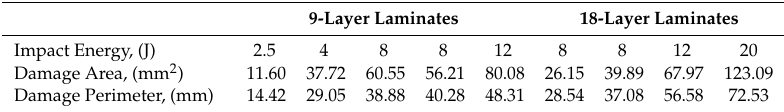
Table 3. Dilatational characteristics of damage caused on thin and thick composite specimens at di ff erent impact energy